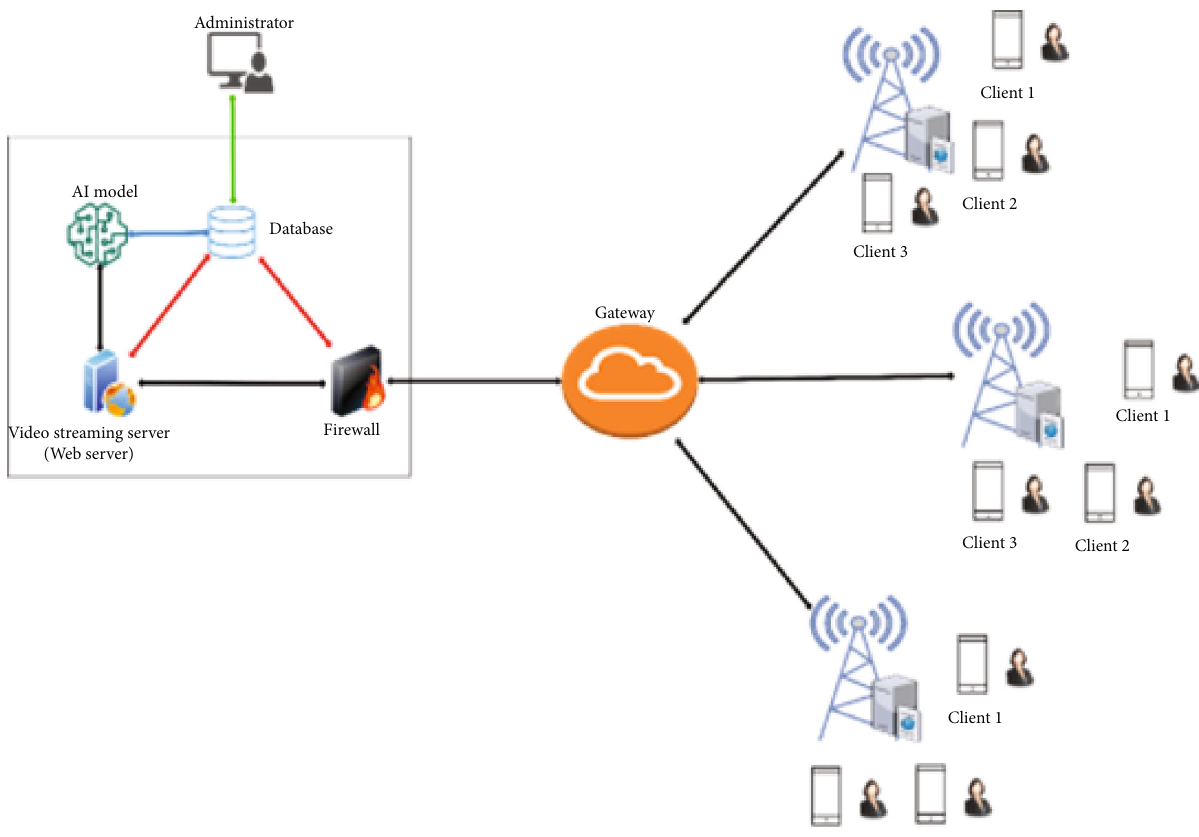
Figure 1: Proposed framework architecture for mobile